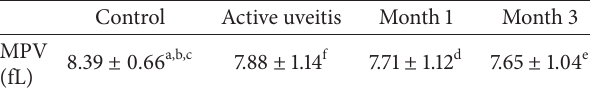
Table 1: Mean platelet volume (MPV) in